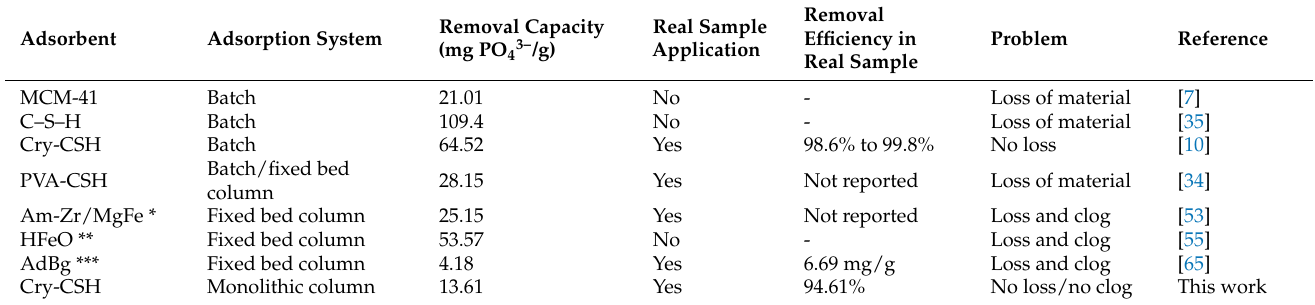
Table 5. Comparison of Cry–CSH column with various adsorbents for phosphate removal.